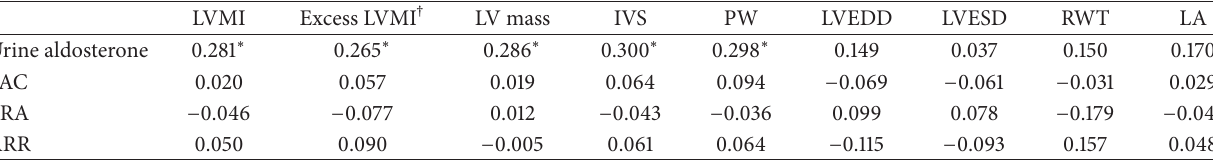
Table 4: The correlation of urine aldosterone level and LV wall thickness, dimension, and LA size in patients with PA (groups 2 and 3).